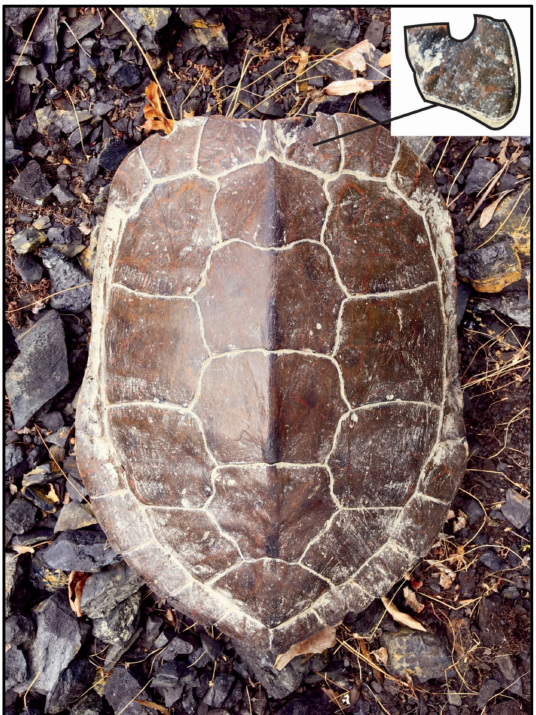
Figure 3. Adult female Northern Map Turtle AKO marked as a hatchling in 2007 and recaptured at age 14 on the coal pile. Curved notches are characteristic of adult turtles marked as